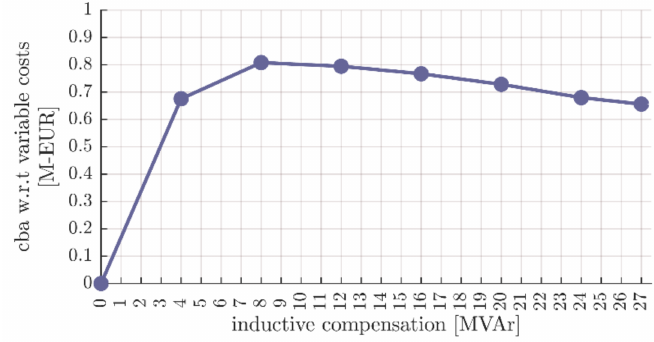
Figure 10. Cost-benefit analysis for various reactor